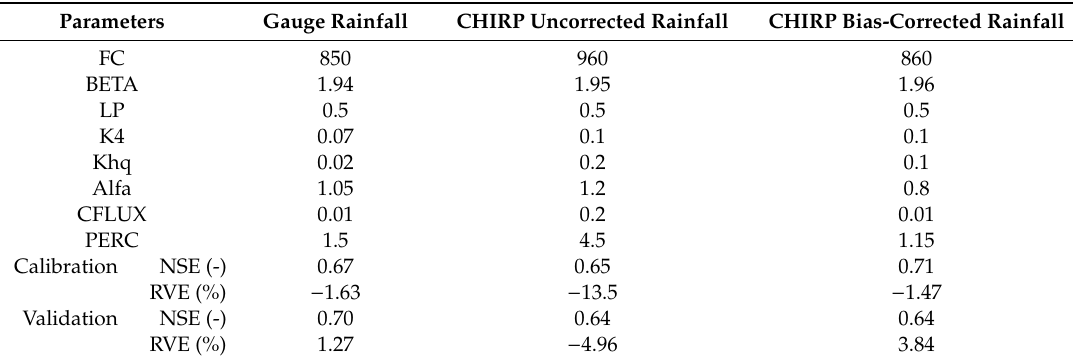
Table 6. Calibrated model parameter values and their performance for gauged, uncorrected, and bias-corrected CHIRP rainfall estimate for Meki